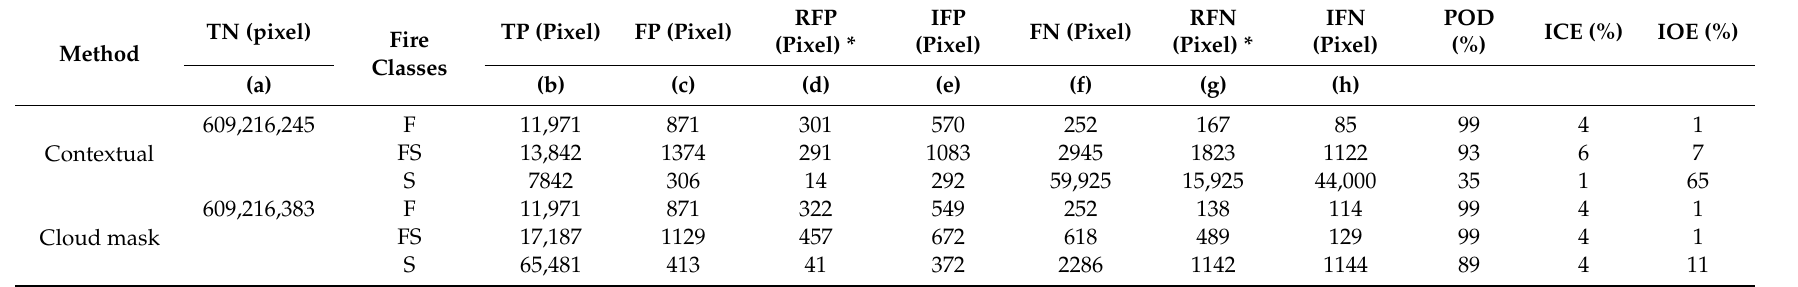
Table A2. As per Table A1 but showing the comparison of fire classes, i.e., flaming (F), smouldering (S), and mix of flaming and smouldering (FS).